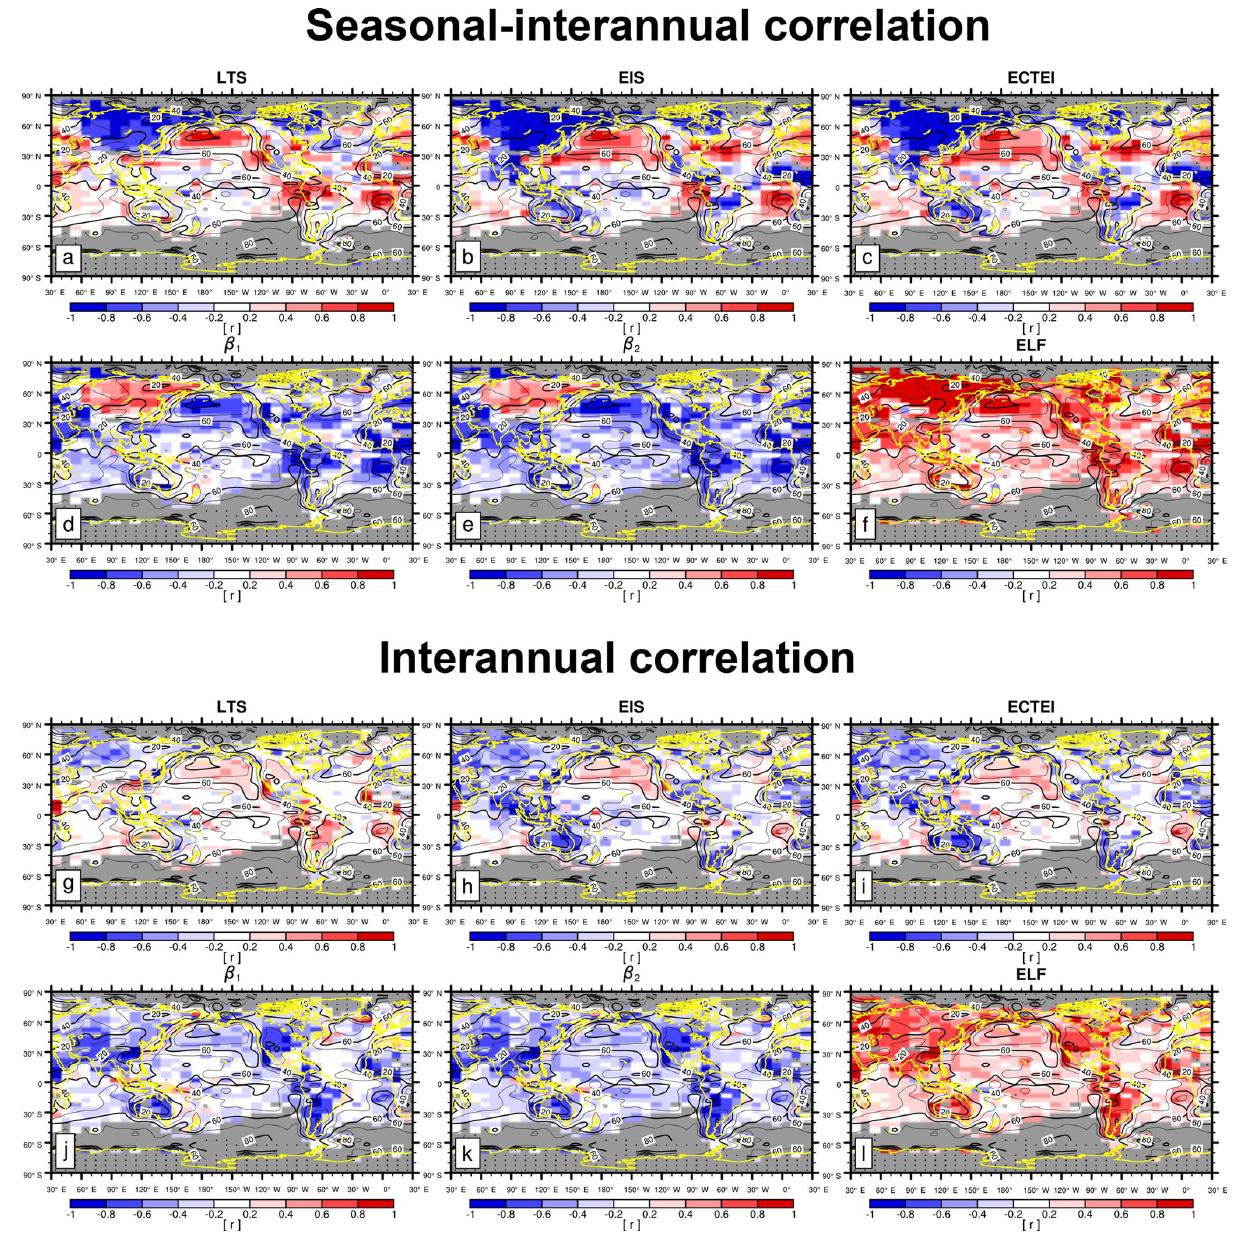
Figure 13. Global distribution of seasonal–interannual (a–f) and interannual (g–l) correlation coefficients between the seasonal LCA and six key proxies (LTS, EIS, ECTEI, β 1 , β 2 , and ELF). The contour line denotes the climatological annual LCA reported by surface